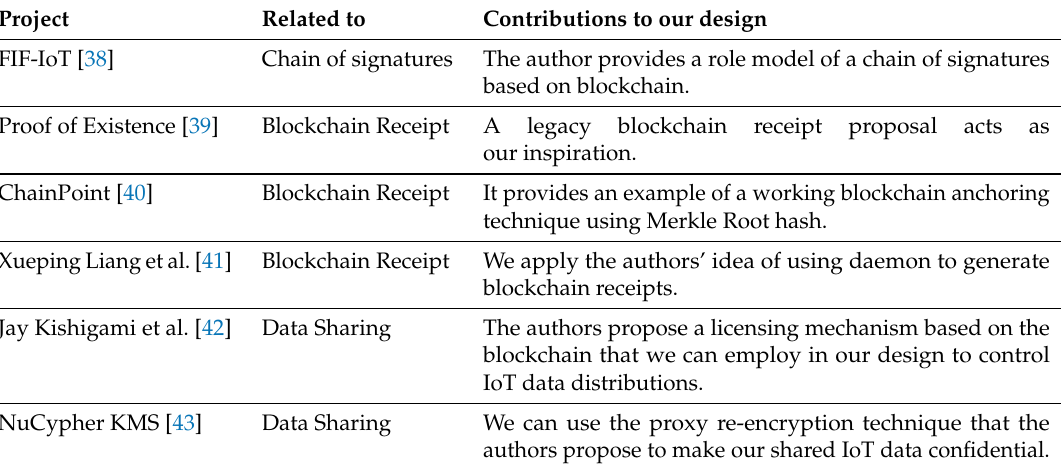
Table 4. The list of related works serving as building blocks for our data at rest solutions.